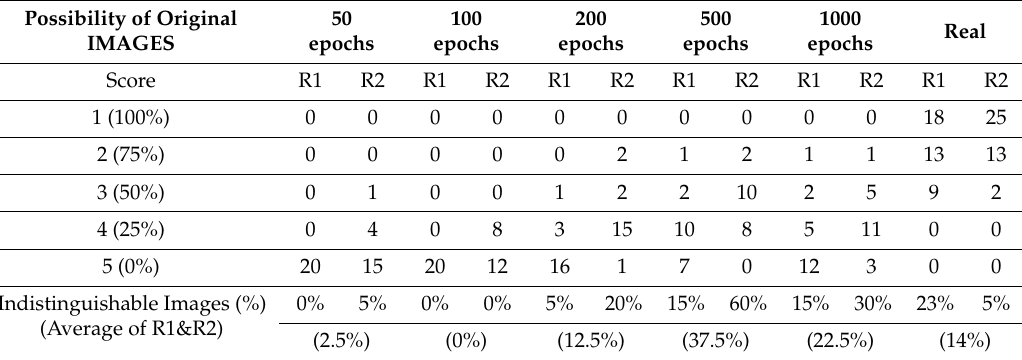
Table 5. Evaluation for possibility of original